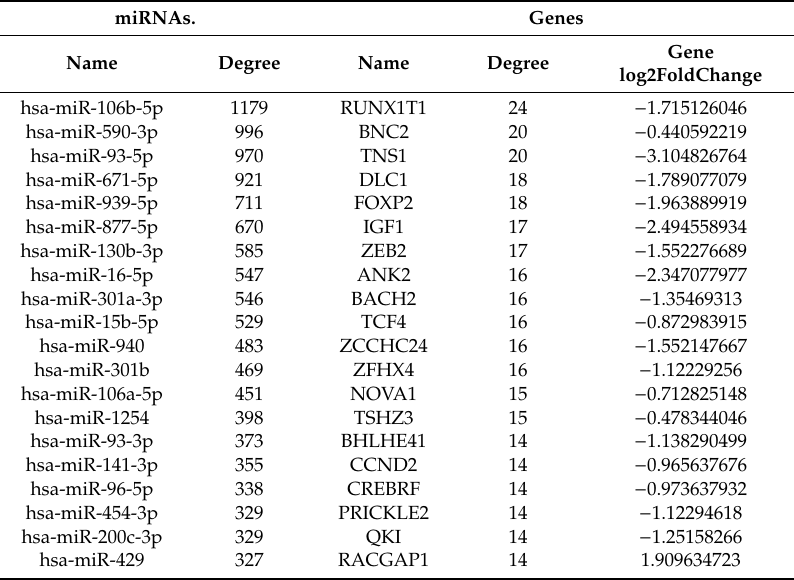
Figure 3. miRNA master regulators in breast cancer. The heatmap represents the log2 fold change expression of each miRNA target, where red shows an overexpression and blue a downregulation in BC tissues. The right bar shows the global regulation activity of each miRNA related to its multiple targets, represented as the normalized enrichment score (NES), where blue represents a negative NES and red a positive. As shown, all of the miRNAs exhibit a negative NES. Table 1. Top degree miRNAs and genes in the